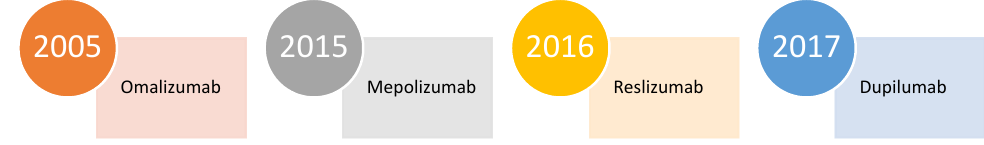
Figure 1. Developmental timing of monoclonal antibodies used for treating allergic